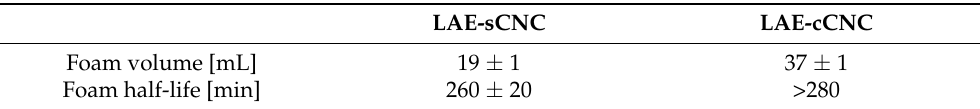
Table 1. Initial foam volume and foam half-life in LAE 0.006 wt.%—CNC 0.3 wt.% dispersions with respect to CNC hydrophilic groups.